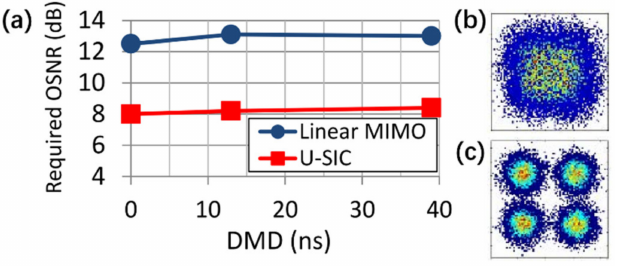
Figure 11. ( a ) Required OSNR to achieve HD-FEC limit BER under FMF links with various DMD values. And LP 11a -X signals detected through a linear MIMO equalization ( b ) or through a U-SIC scheme ( c ) after transmission over 15-km FMF at OSNR of 8